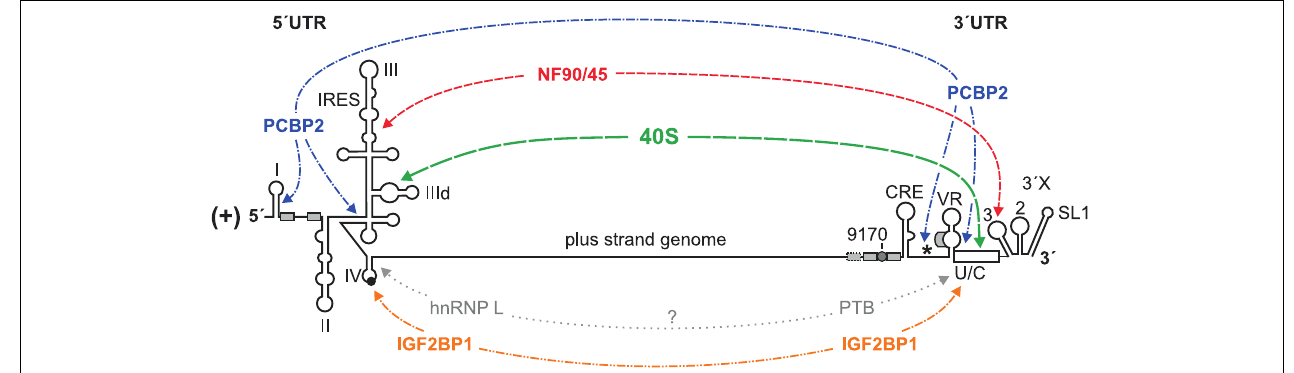
FIGURE 4 | Long-range interactions of the HCV genome ends mediated by trans -acting factors. The small ribosomal 40S subunit interacts with the lower part of the SL III domain in the HCV 5 (cid:48) UTR and with the HCV 3 (cid:48) UTR, preferentially with the poly(U/C) tract (U/C). The NF90/NF45 complex interacts with the upper part of the SL III domain in the 5 (cid:48) UTR and with the SL 3 in the 3 (cid:48) UTR. PCBP2 interacts with each two sites in the 5 (cid:48) UTR and in the 3 (cid:48) UTR. IGF2BP1 (or IMP1) interacts with the 3 (cid:48) region of the IRES and with the poly(U/C) tract of the 3 (cid:48) UTR. A hypothetical interaction (shown by gray dotted lines) may also involve hnRNP L (which binds the 3 (cid:48) region of the IRES) and PTB [which binds the poly(U/C) tract]. In addition, cooperative aggregation of miR-122/Ago complexes may also be hypothesized to contribute to the RNA end-to-end communication (not illustrated in the